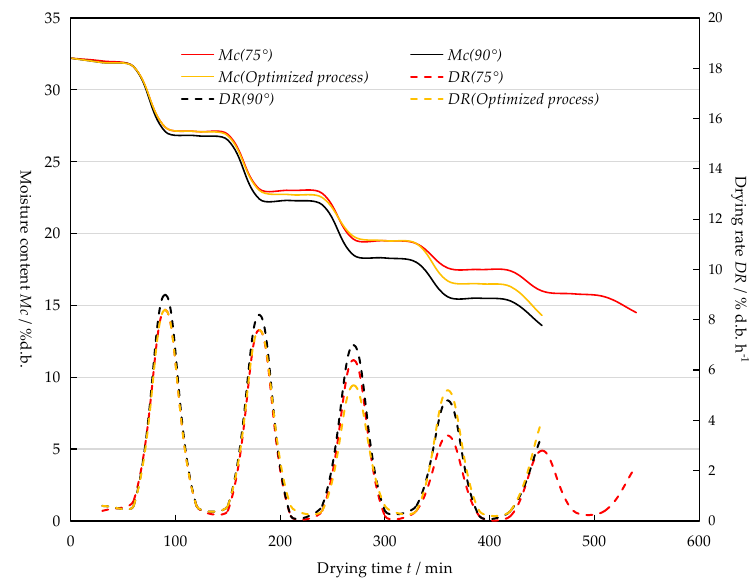
Figure 3. The variation of moisture content and drying rate with drying times for different valve openings.